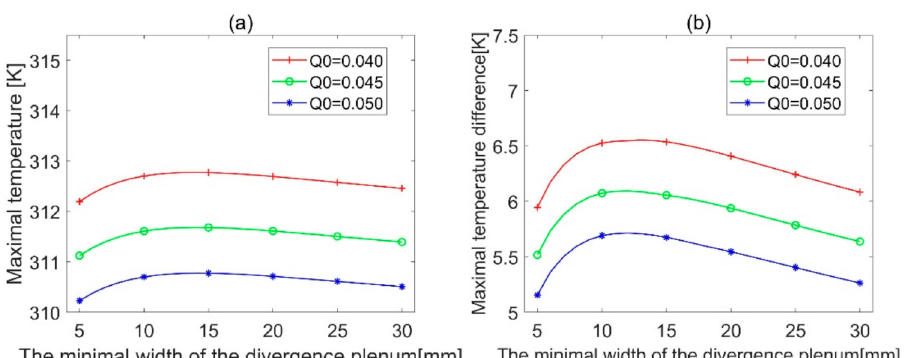
Figure 11. The effect of the minimal width of the divergence plenum on the temperature distribution for various inlet airflow rates. ( a ) effect on maximal temperature, ( b ) effect on maximal temperature difference. ( θ dp = 15 ◦ , θ cp = 15 ◦ , d 0 = 1 mm, w cp = 5